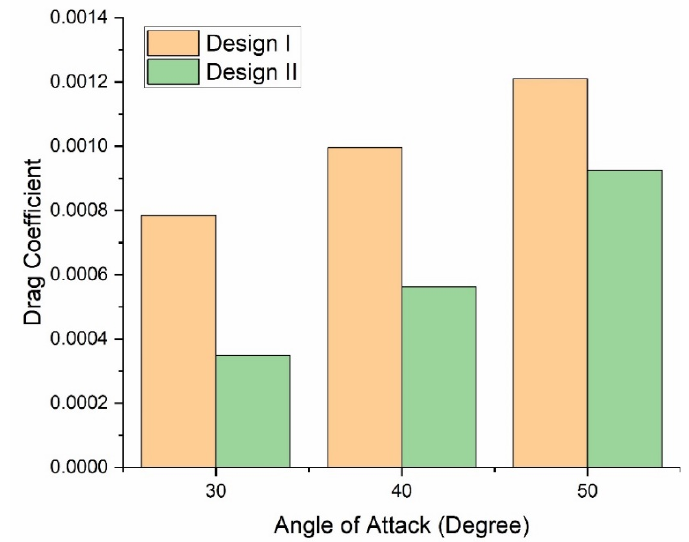
Figure 12. Comparison of simulated values of drag coefficient of design I and Design II of bullet heads at 30°, 40°, and 50° angle of attack.